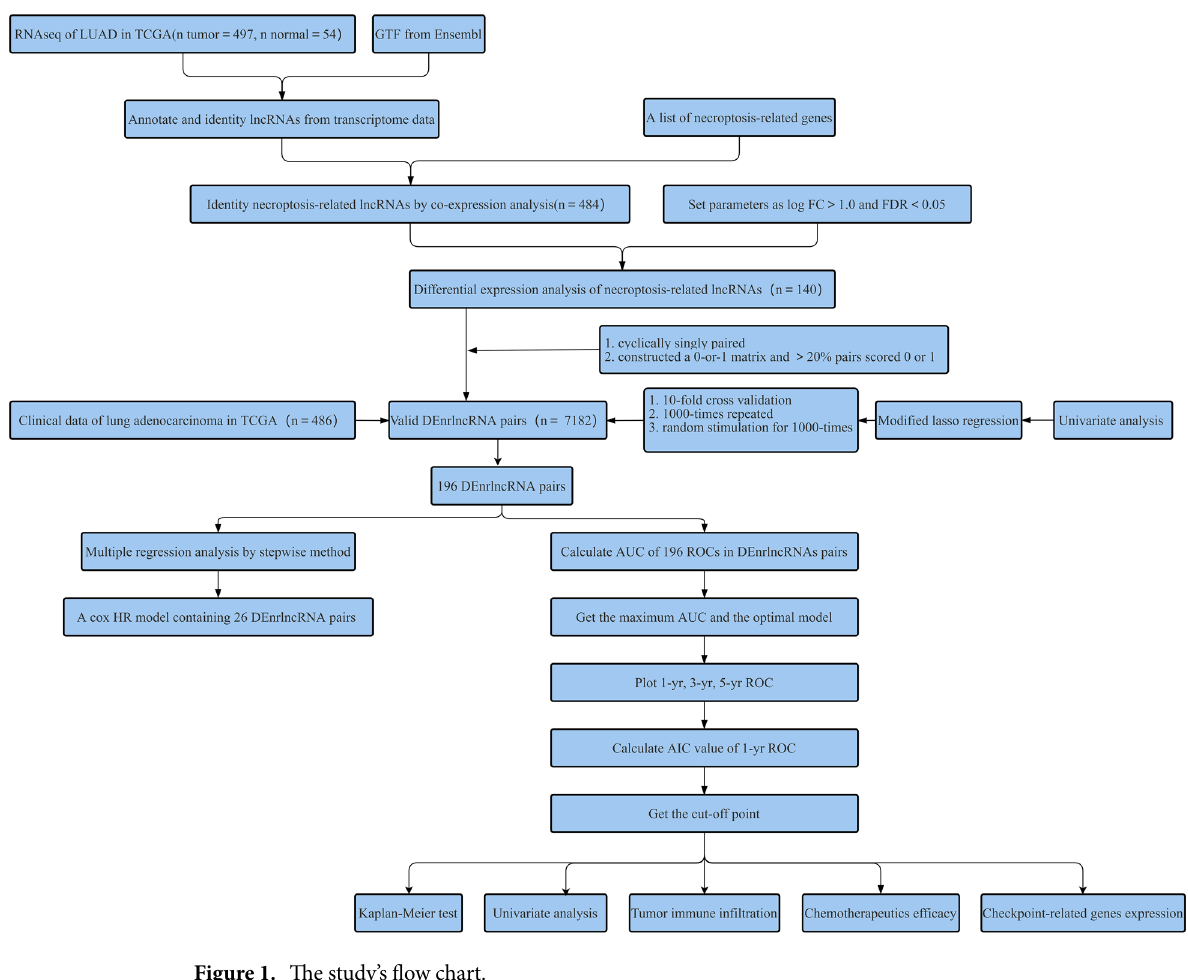
Figure 1. The study’s flow